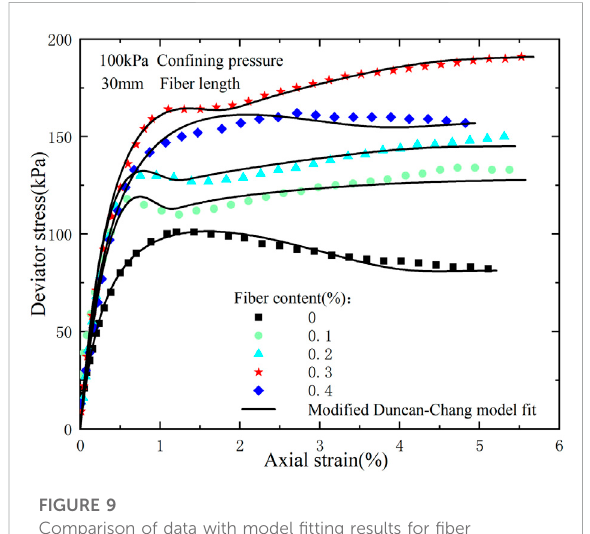
FIGURE 9 Comparison of data with model fi tting results for fi ber content 0% – 0.4%.